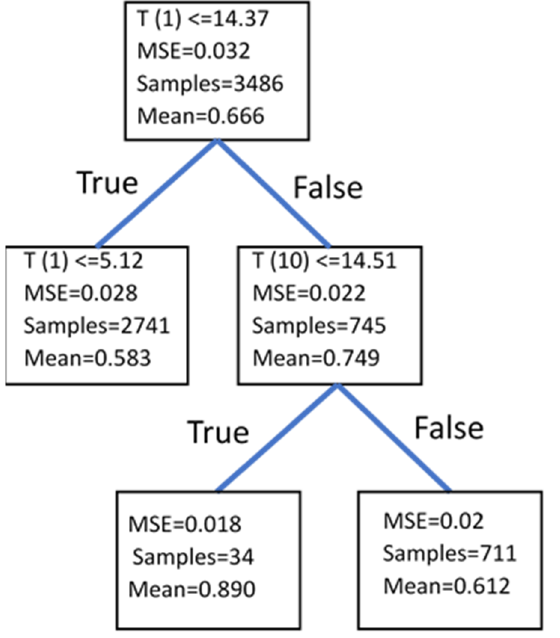
Figure 3. Illustrative example of a two-level regression tree to segregate streambed exchange flux based on subsurface temperature observations at ten depths T(0), T(1) … T(10).